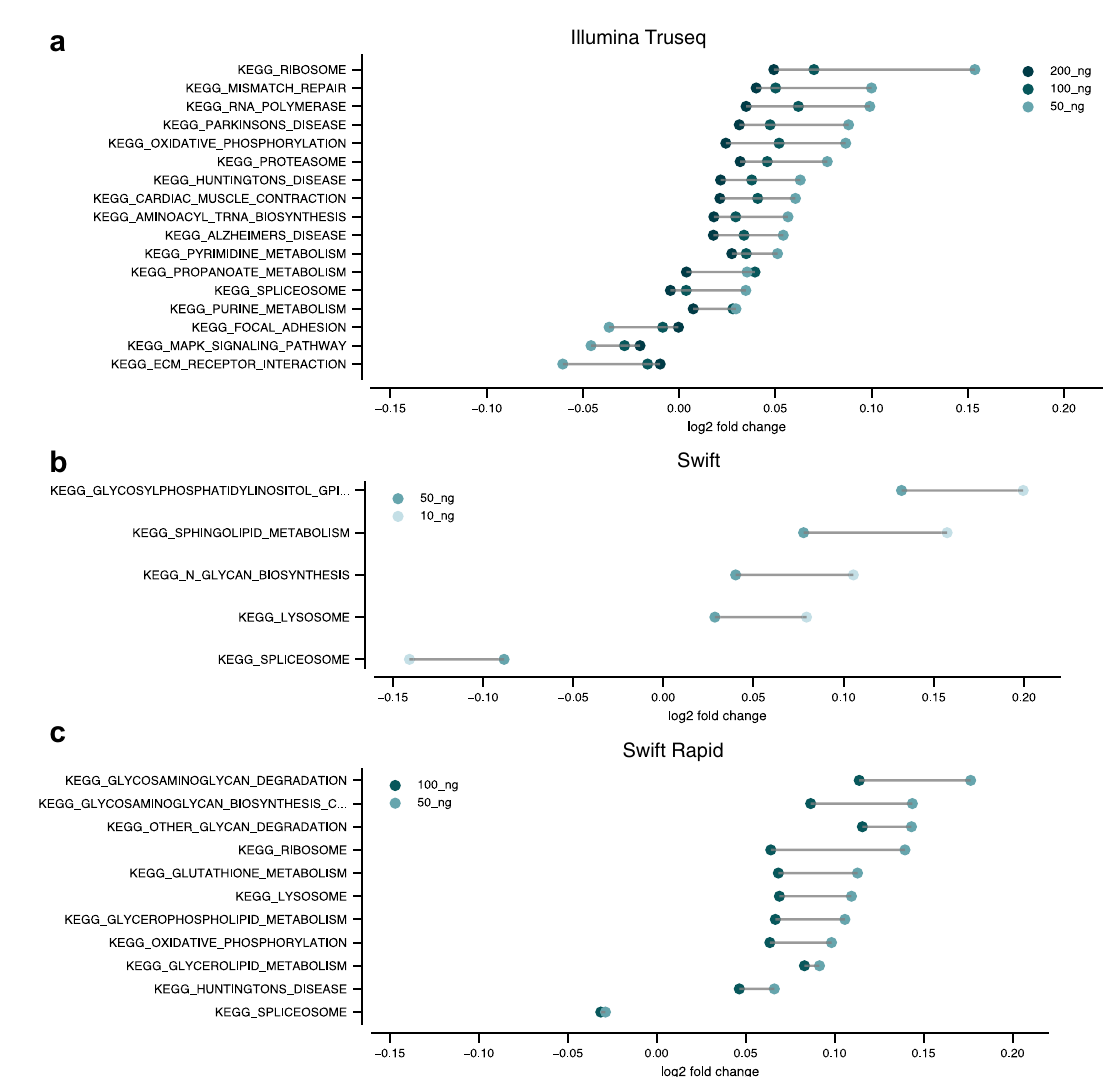
Figure 6. Comparison of differential gene expression results. Number of differentially expressed genes at a given level of significance depends on input amount. Differential expression computed with respect to reference samples prepared with ( a ) the Illumina TruSeq kit with 500 ng input, ( b ) the Swift RNA kit with 100 ng input, and ( c ) the Swift Rapid RNA kit with 200 ng input.